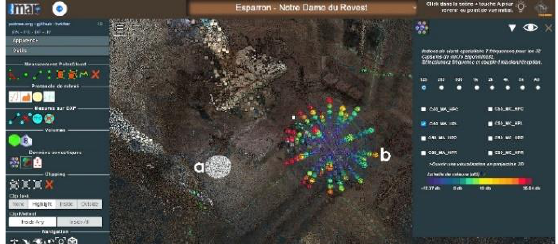
Figure 9 : Visualisation of the 32-channel C50 clarity indicator for the left emission point (white sphere in a ). information: quantitative value (colour), angular position, and frequency. Unsurprisingly high values occur closer to